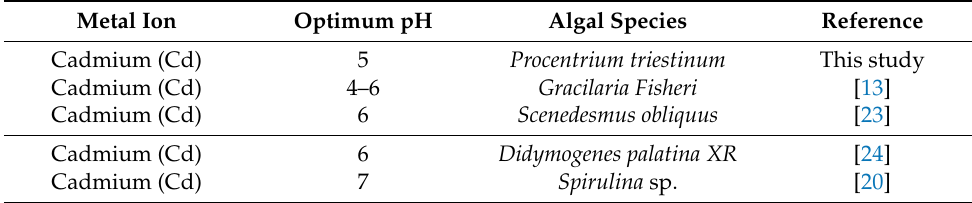
Table 3. Comparison on optimum pH of cadmium sorption among different algal